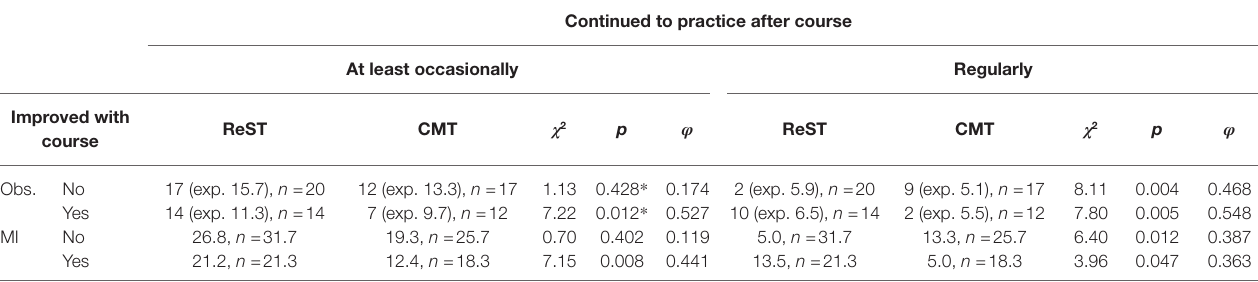
TABLE 3 | The relationship between improvement in psychological functioning observed directly after the course, as determined by a reliable change index, and continued mindfulness practice in the following 6 months.